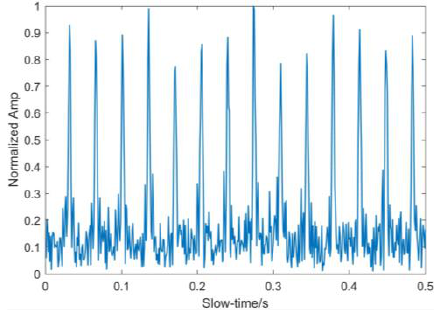
Figure 11. The range profiles.